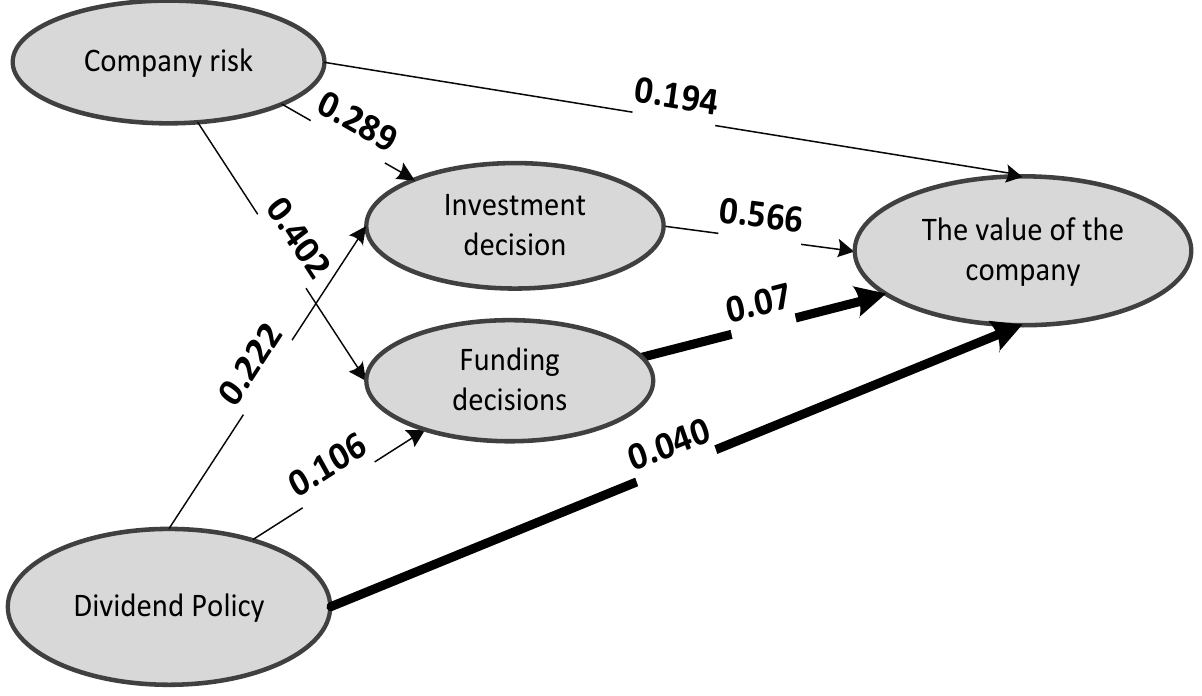
Figure 6. Effect of Risk Analysis Results in WarpPLS Dividend Policy of the Company and Investment Decisions, Decisions Funding to Company